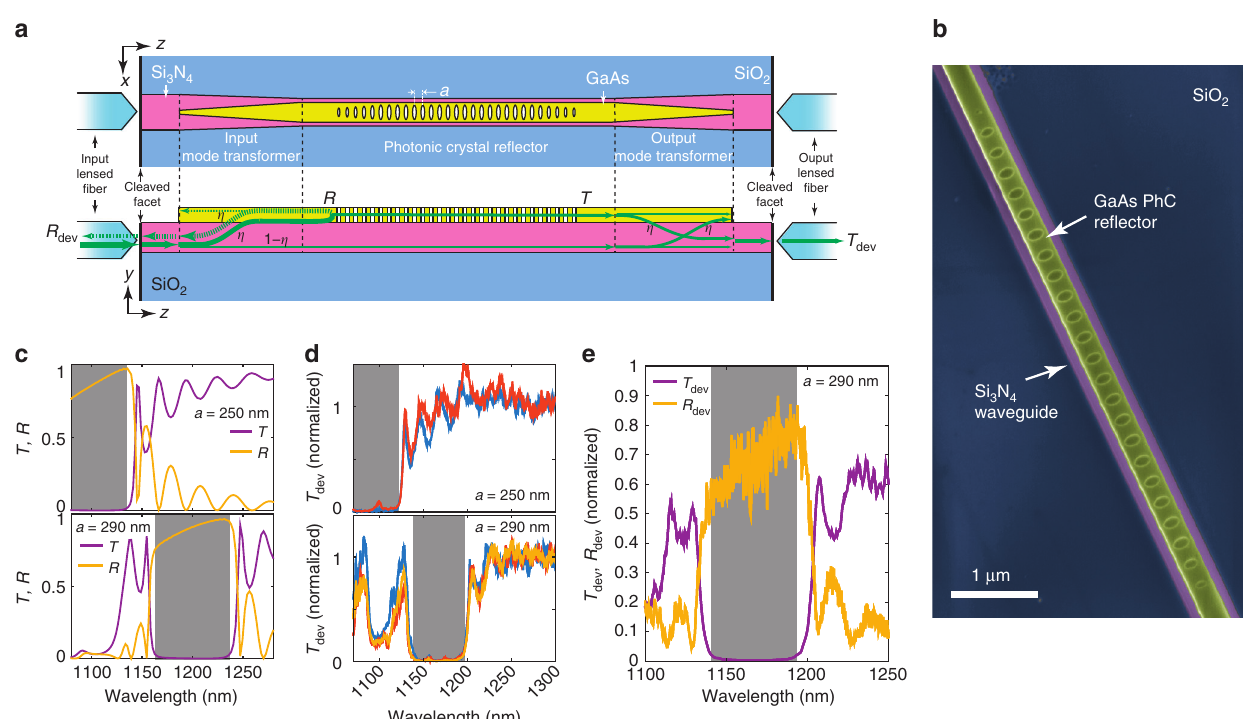
Fig. 4 Characterizing mode transformer ef fi ciency with a photonic crystal re fl ector. a Schematic of a PhC re fl ector device. Top: top-view. Bottom: cross- section. Green arrows indicate pathways taken by the optical signal injected at the input port. R and T stand for PhC modal power transmission and re fl ection spectra, and T dev , R dev transmission and re fl ection spectra through the entire device, including lensed fi bers. b False-color SEM of fabricated GaAs PhC re fl ector (yellow) on top of a Si 3 N 4 (pink) waveguide, on top of exposed SiO 2 (blue). c FDTD-simulated TE modal transmission ( T , purple) and re fl ection ( R , yellow) spectra as a function of wavelength for the PhC (without mode transformers), for two different lattice constants a . d Experimental transmission spectra for various PhC re fl ectors with a = 250 nm (top) and a = 290 nm (bottom), normalized fi rst to the transmission spectrum of a baseline Si 3 N 4 waveguide (without GaAs sections), then to the mean transmission at wavelengths between 1250 and 1300 nm. Different colors indicate different devices. e Experimental transmission and re fl ection spectra for a PhC re fl ector with a = 290 nm, normalized to the transmission spectrum of a baseline Si 3 N 4 waveguide. Gray areas have transmission < − 15 dB in ( c , d ), < − 20 dB in ( e